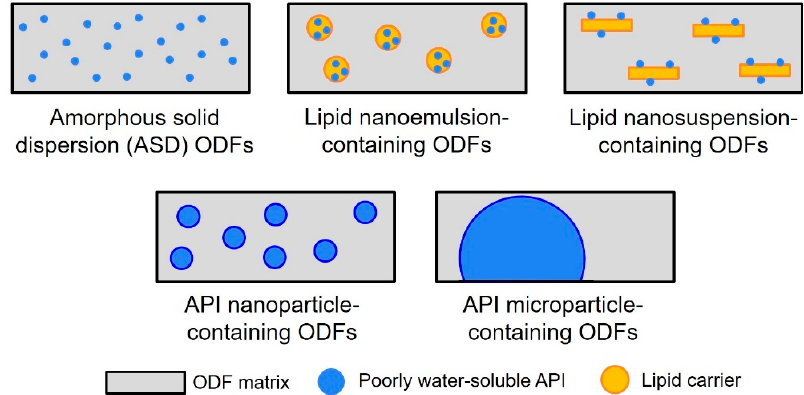
Figure 1. Formulation strategies for the embedding of poorly water-soluble APIs in ODFs.